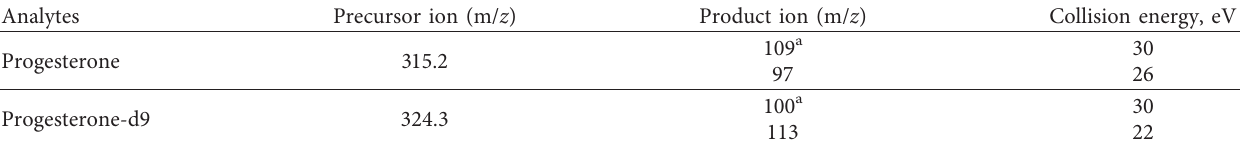
Table 1: Multiple reaction monitoring conditions of progesterone and progesterone-d9.